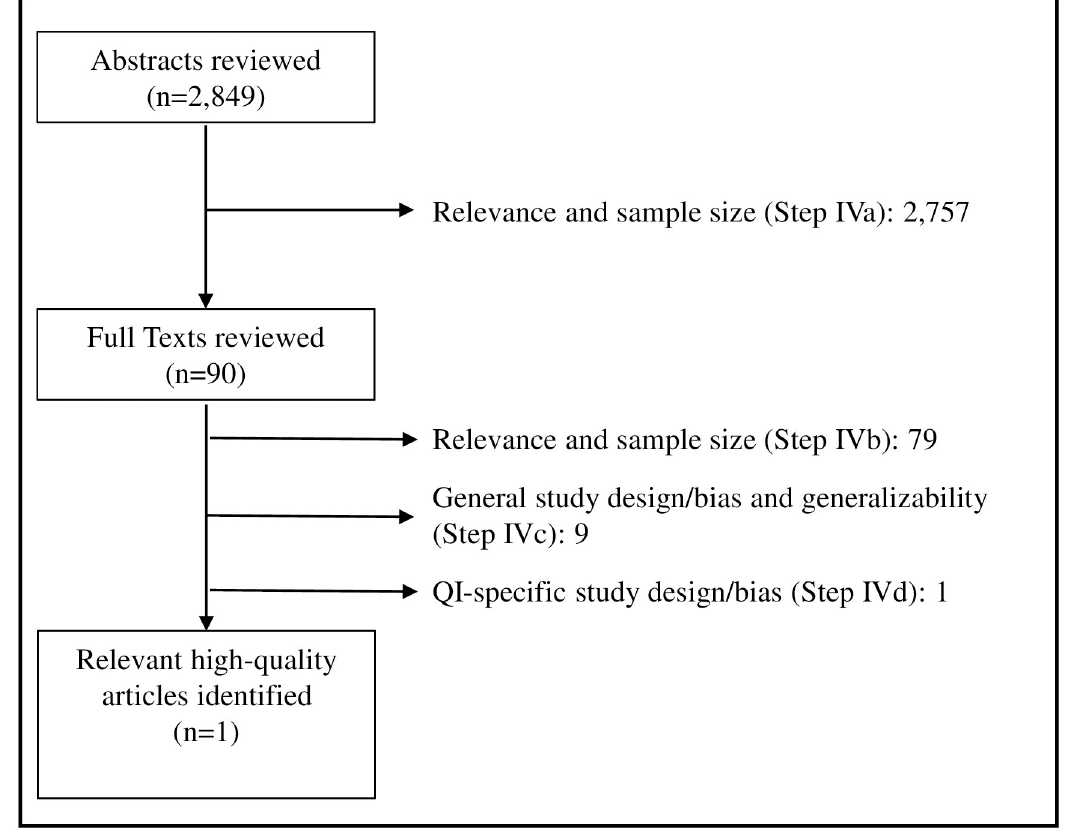
Fig 4. Flow diagram for the GOSE abstract and full-text review process. The EB-COP uses a two-step review process which begins with the abstract and progresses to full-text review. The arrows and numbers indicate the reasons articles were excluded from the review, and the number of articles that were excluded for each reason,